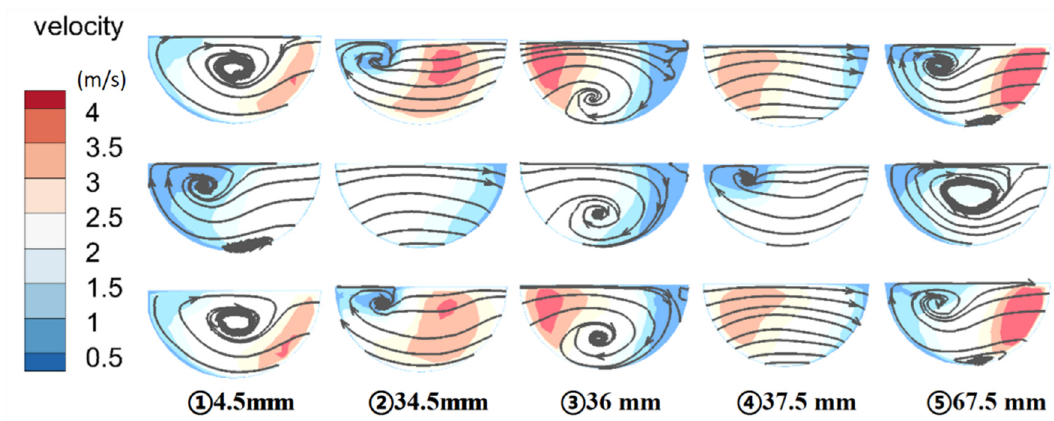
Figure 15. Variation of streamlines in sections at different distances from the cold fluid inlet. (original structure: rotation angle θ = 0°).